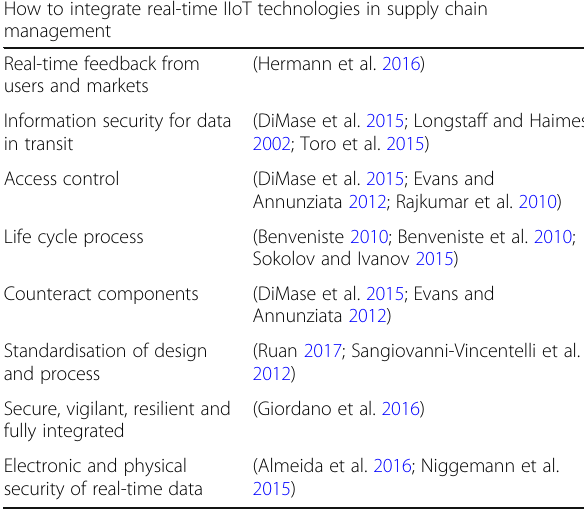
Table 4 How to integrate real-time IIoT technologies in